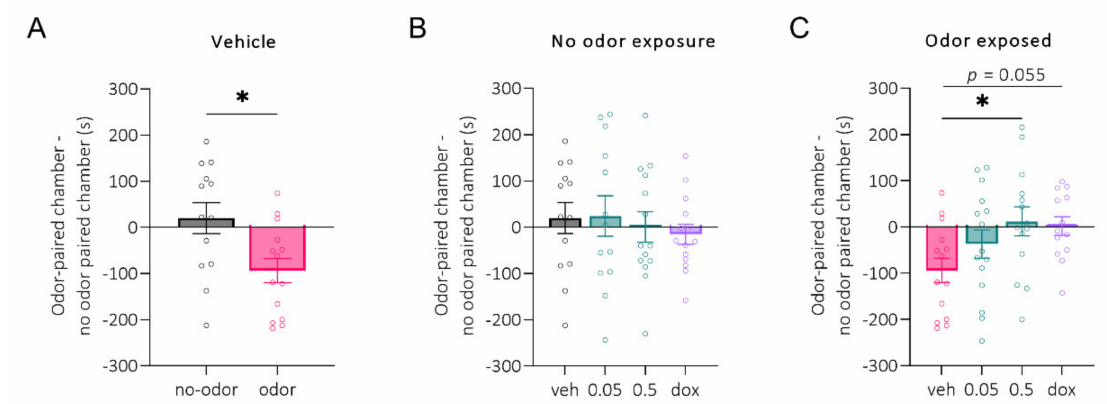
Figure 2. Conditioned place aversion to predator odor in rats treated with LCGA-17 at the dosages indicated or doxazosin (dox, 1 mg/kg). Drugs were administered twice: after conditioning with odor/no odor and the next day 30 min before the test. ( A ) Predator odor induced significant place aversion in the vehicle-treated groups (t (27) = 2.690, p = 0.012; two-tailed unpaired t -test); ( B ) No odor-conditioned animals showed no place aversion 24 h post-exposure, independent of the treatment (F (3, 50) = 0.29, p = 0.83; ANOVA); ( C ) LCGA-17 at a dose of 0.5 mg/kg was more efficient in reducing odor-induced place aversion than dox (F (3, 52) = 2.9, p = 0.04; ANOVA, Dunnett’s test). * p < 0.05 vs. vehicle odor-exposed